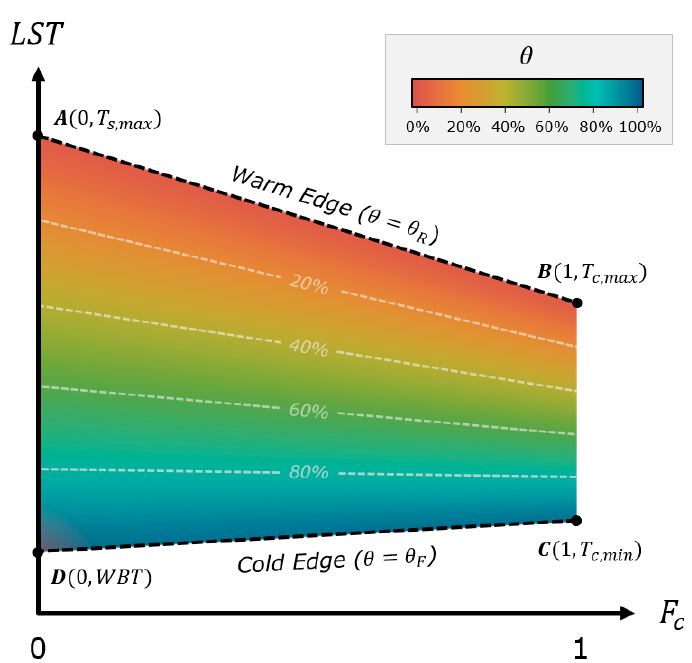
Figure 4. Trapezoidal LST-Fc space is used to derive the relative root zone soil moisture content ( θ ) based on satellite-based thermal (LST) and vegetation cover (Fc) data. The warm and cold edges of the trapezoid define at which LST and Fc value combination θ is equal to the residual moisture content ( θ R ) or the field capacity ( θ F ), respectively. Both the warm and cold edges are derived using meteorological data on a pixel level. Points A and B of the trapezoidal space define the warm edge using the maximum surface temperature of bare (T s,max ) and fully covered (T c,max ) pixels. Point C defines the cold edge of fully covered pixels using the minimum surface temperature (T s,min ). In contrast to Yang et al. [23], point D defines the cold edge of bare pixels using the wet bulb temperature (WBT) instead of the minimum surface temperature (T c,min ) to increase the accuracy of the model for bare soil conditions.